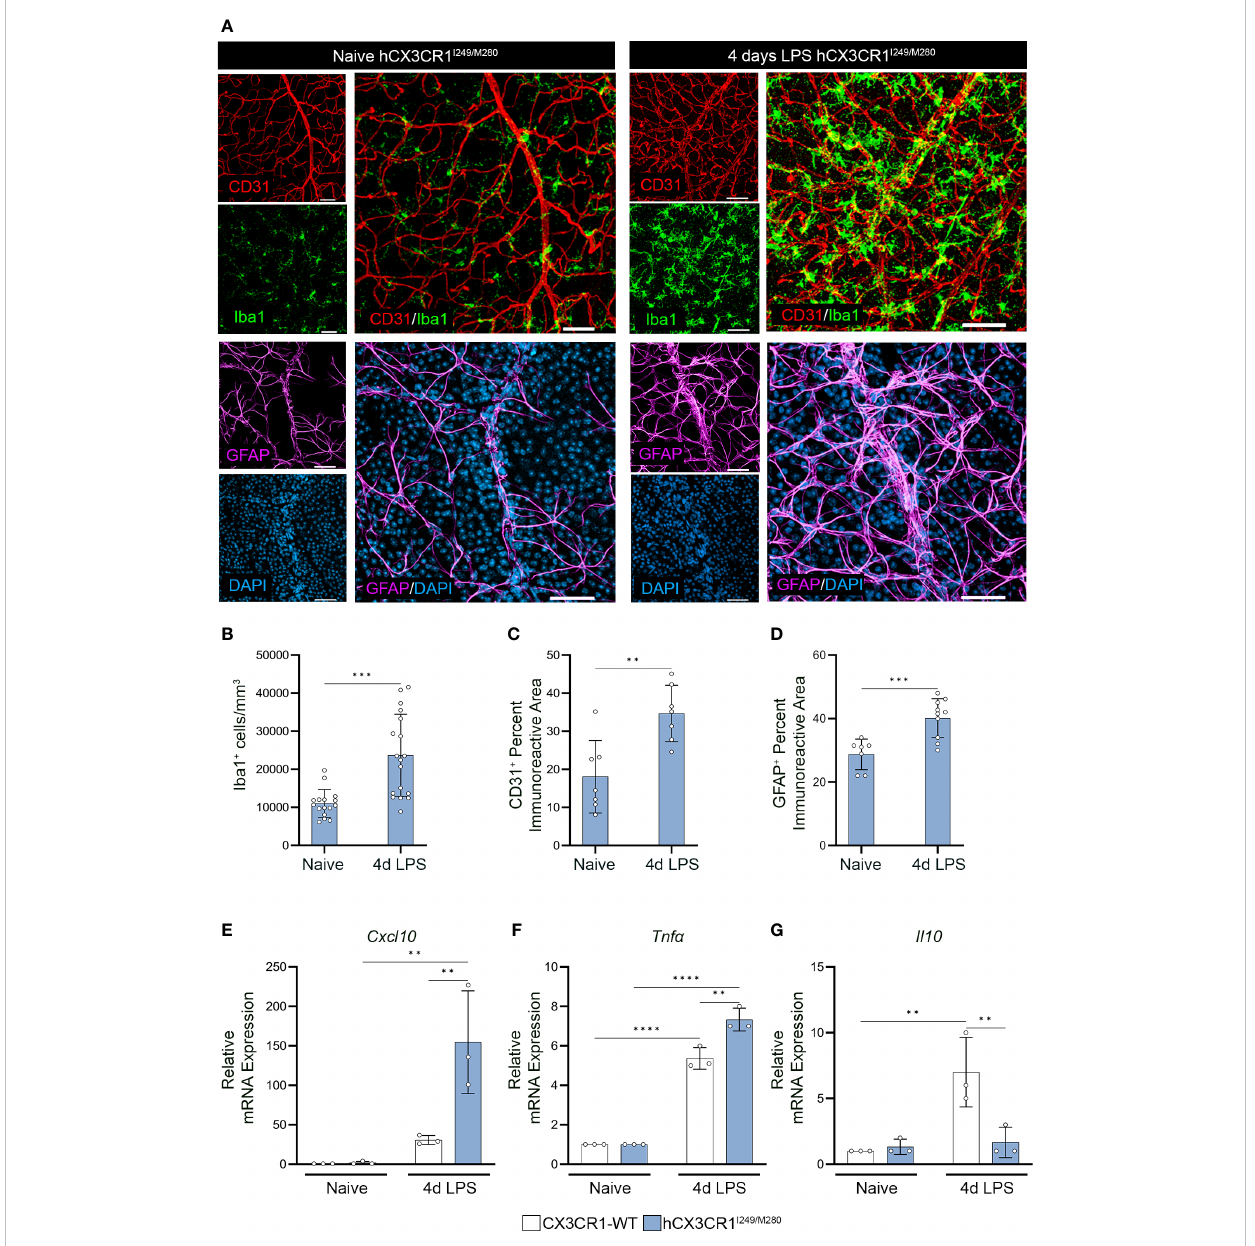
FIGURE 1 Acute LPS-induced in fl ammation induces aberrant angiogenesis and gliosis in the hCX3CR1 I249/M280 retina. hCX3CR1 I249/M280 mice were i.p. injected with 0.08mg/Kg LPS once daily for four days (4d), and naïve age-matched controls received PBS. (A) Confocal images of retinal tissues stained for Iba1 (green), CD31 (Red), GFAP (magenta) and DAPI (blue) in naïve and 4d LPS hCX3CR1 I249/M280 mice. Confocal images represent the retinal ganglion cell layer in the peripheral retina. (B – D) , Quanti fi cation of retinal IHC analysis for Iba1 + cells/mm 3 (B) , CD31 + percent immunoreactive area (C) , and percent immunoreactive area for GFAP (D) . (E – G) , Graphical representation for RT-qPCR analysis of retinas for relative mRNA expression for Cxcl10 (E) , Tnf a (F) and Il10 (G) . Data show the average of the 2 central, 2 medial and 2 peripheral images taken per mouse. Data show mean ± SD, n = 3 to 10 mice per group where each dot represents an individual mouse. ** P <0.01, *** P <0.001, **** P <0.0001 using Student ’ s t-test, with Welch ’ s correction. Scale bars measure